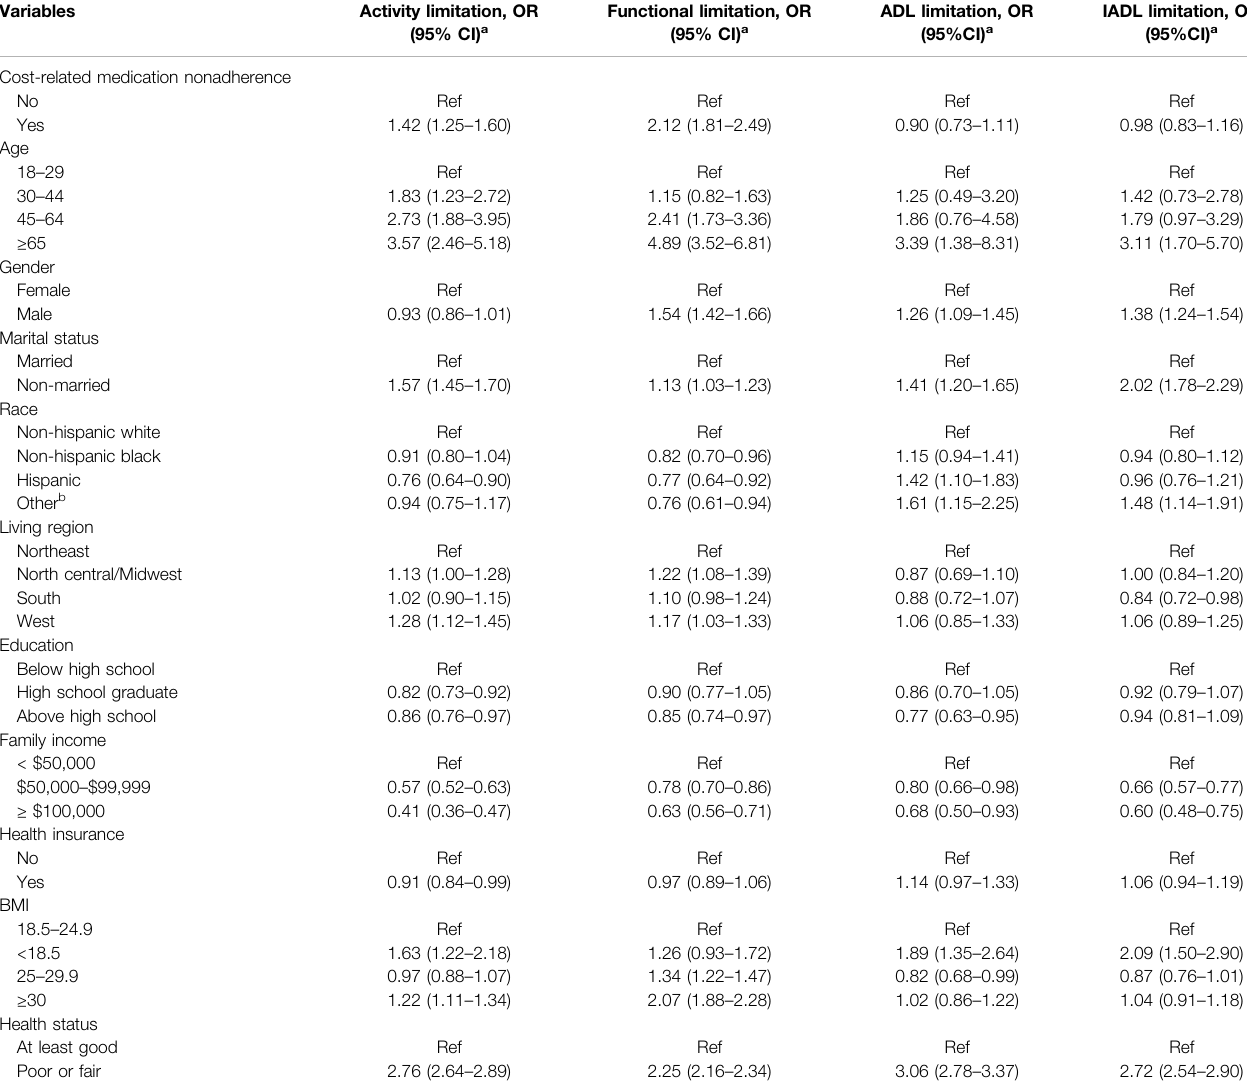
TABLE 3 | The impact of cost-related medication nonadherence on functional abilities among cancer survivors.